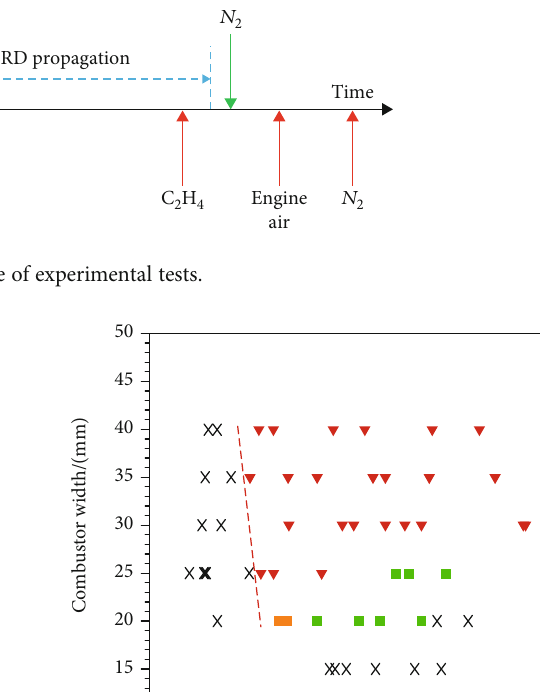
Counter-rotating two-wave